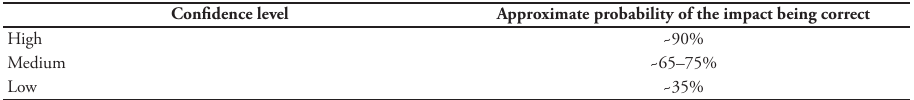
Table 1. The three current confidence levels (high, medium, low) assigned to individual impact reports using the ICAT frameworks. Guiding probabilities are given in the guidelines to aid the assessor in inter- preting their level of confidence into one of the three qualitative